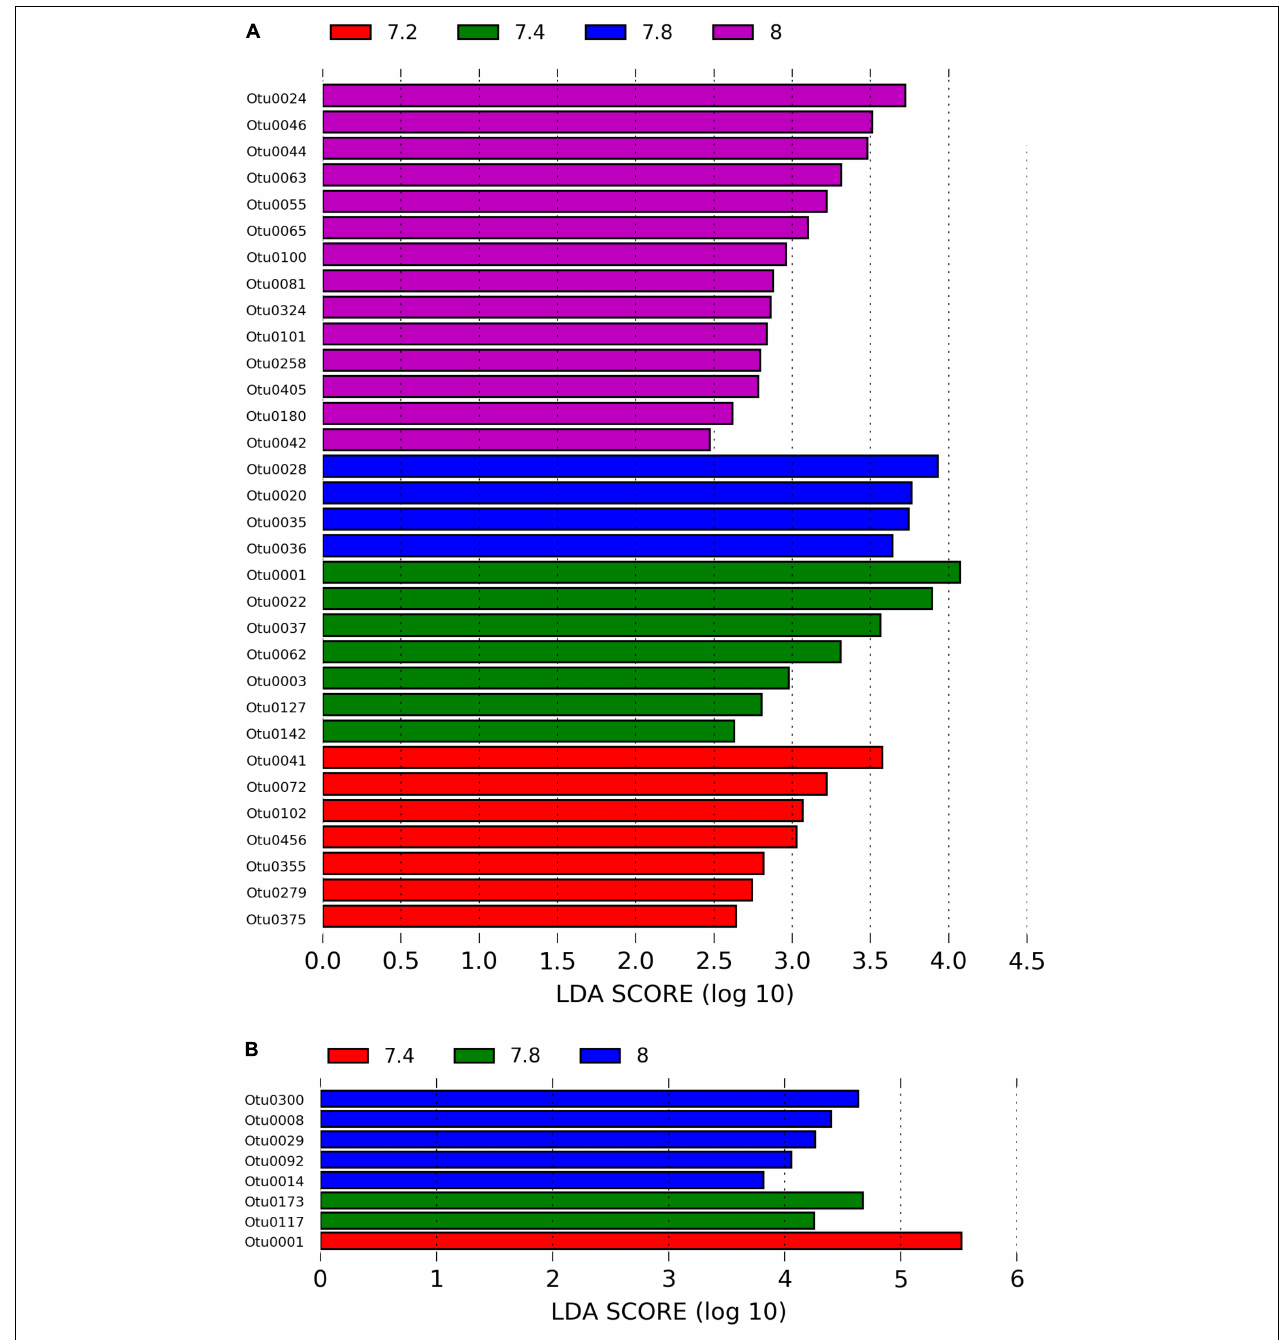
FIGURE 3 | (A) LEfSe analysis identifying representative OTUs from microbial DNA samples and (B) microbial RNA from Stylophora pistillata kept in aquaria for 2 years at different pH treatments (pH 7.2, 7.4, 7.8 and 8.0), with a cutoff value of LDA score (log 10 ) above